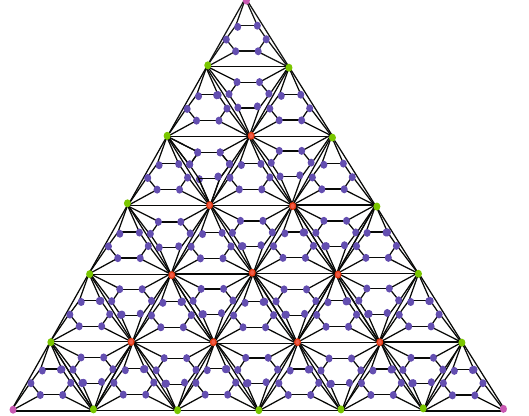
Figure 2: Fourth type of the triangular hex-derived network (THDN4 (7)).